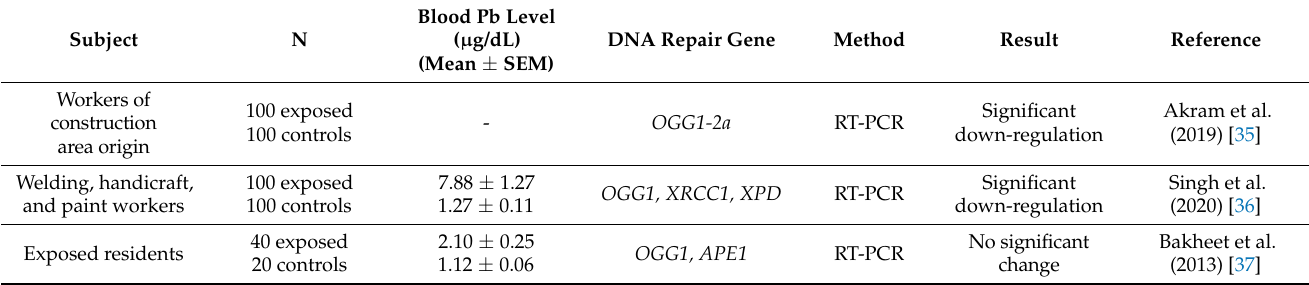
Table 2. Epidemiological studies on the effects of Pb on the expression of DNA repair-related